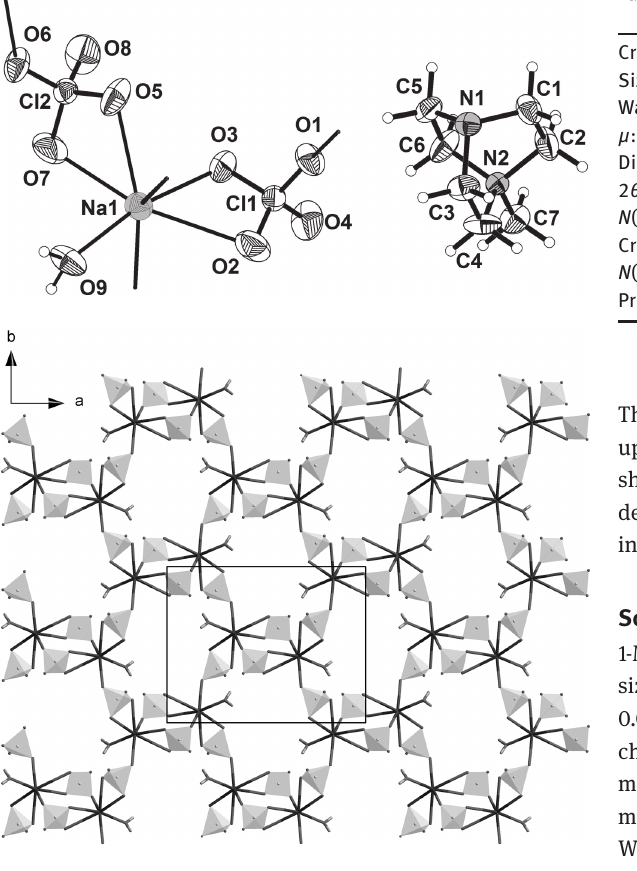
Table 1: Data collection and